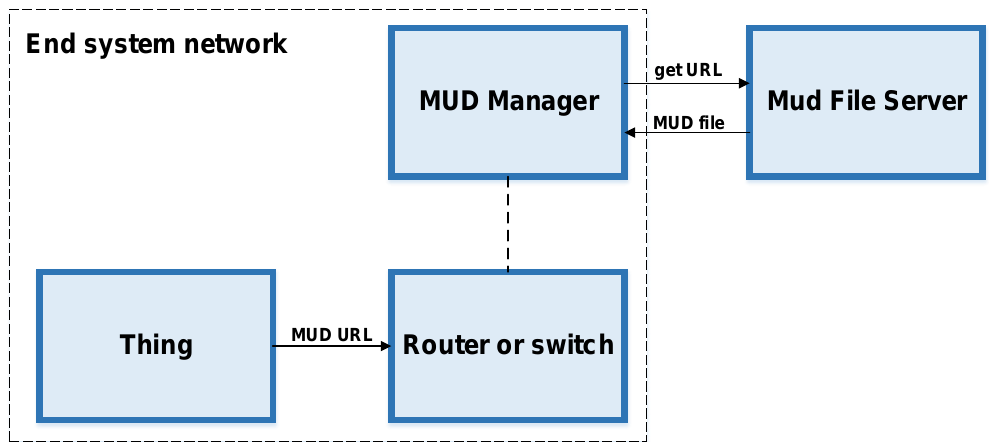
Figure 1. Manufacturer Usage Description